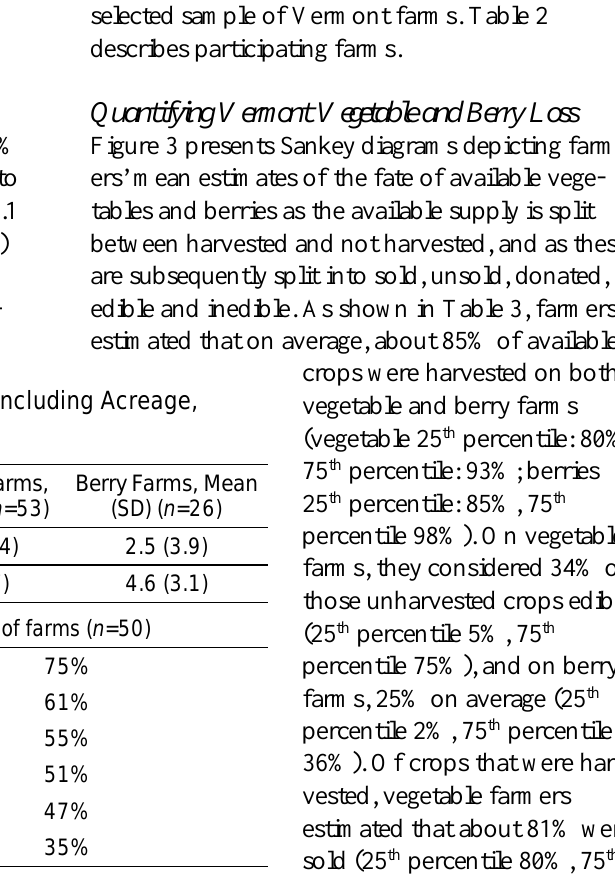
Figure 3. Fate of Available (a) Vegetables and (b) Berries, Based on Survey Performed in Vermont, 2016 (a)